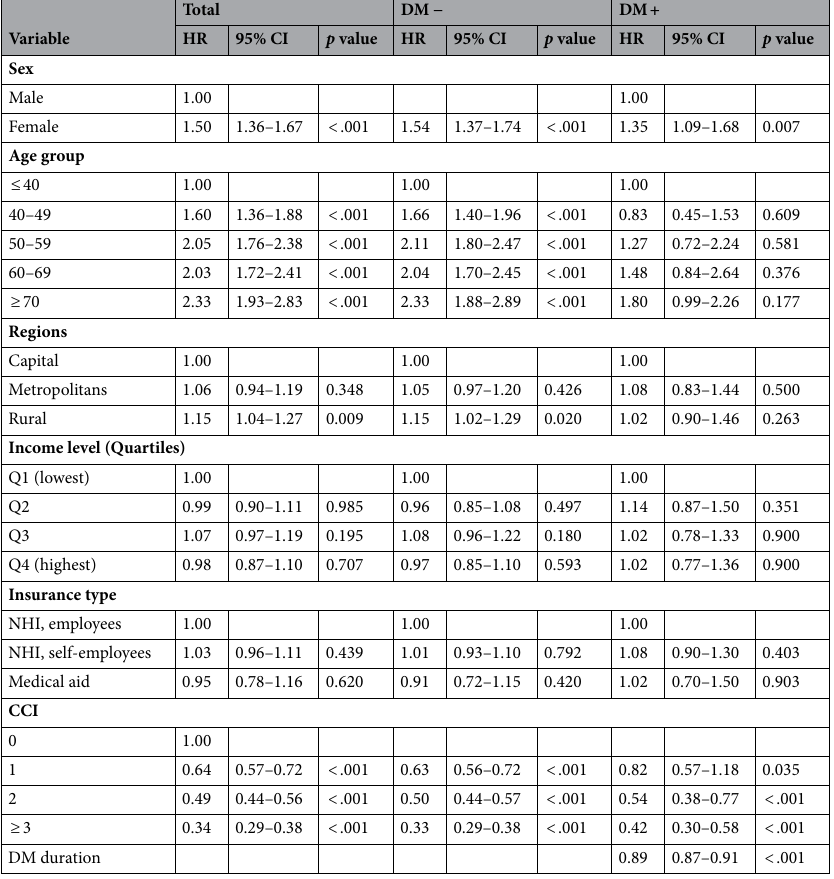
Table 2. Adjusted Hazard ratio for CTS release according to DM presence. CCI: Charson comorbidity index.